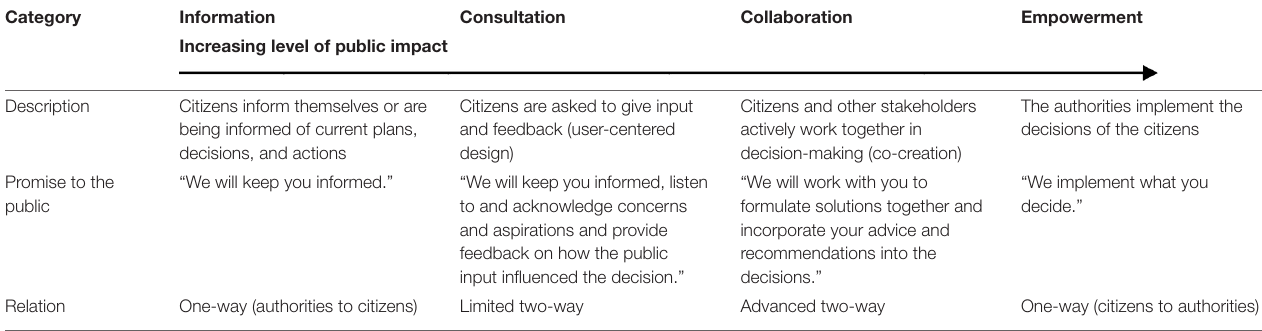
TABLE 3 | Classification of participation in urban development [modified from (21) based on Wouters et al.